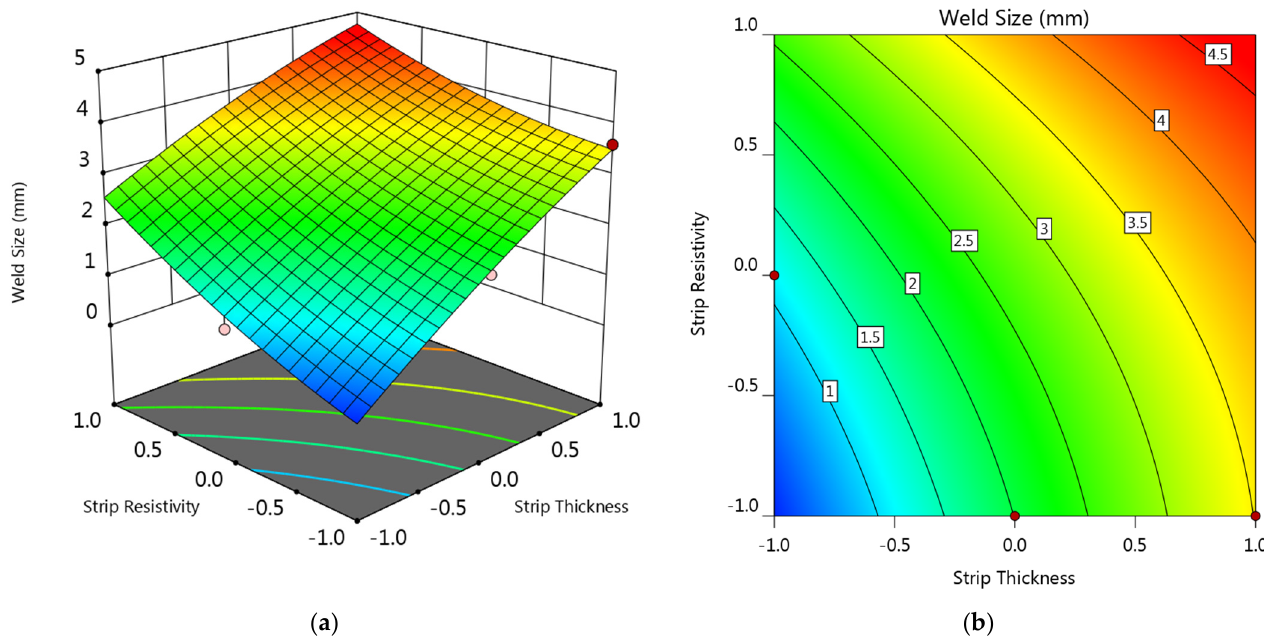
Figure 11. ( a ) Response surface and ( b ) contour plot showing the effect of factor A and C on the weld diameter at B = 0 and D = − 1.